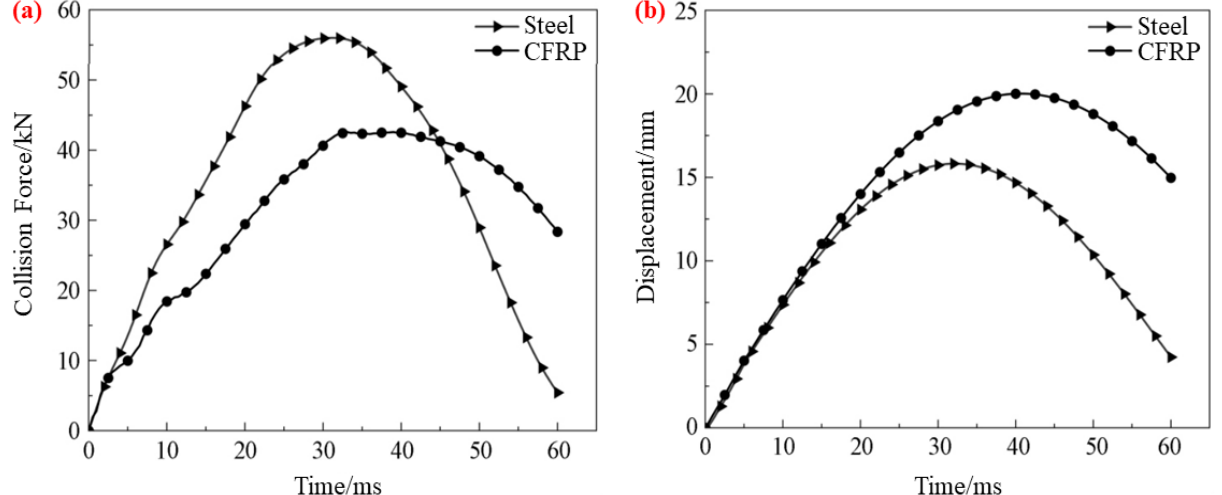
Figure 17. ( a ) Displacement – time curve. ( b ) Collision force – time curve